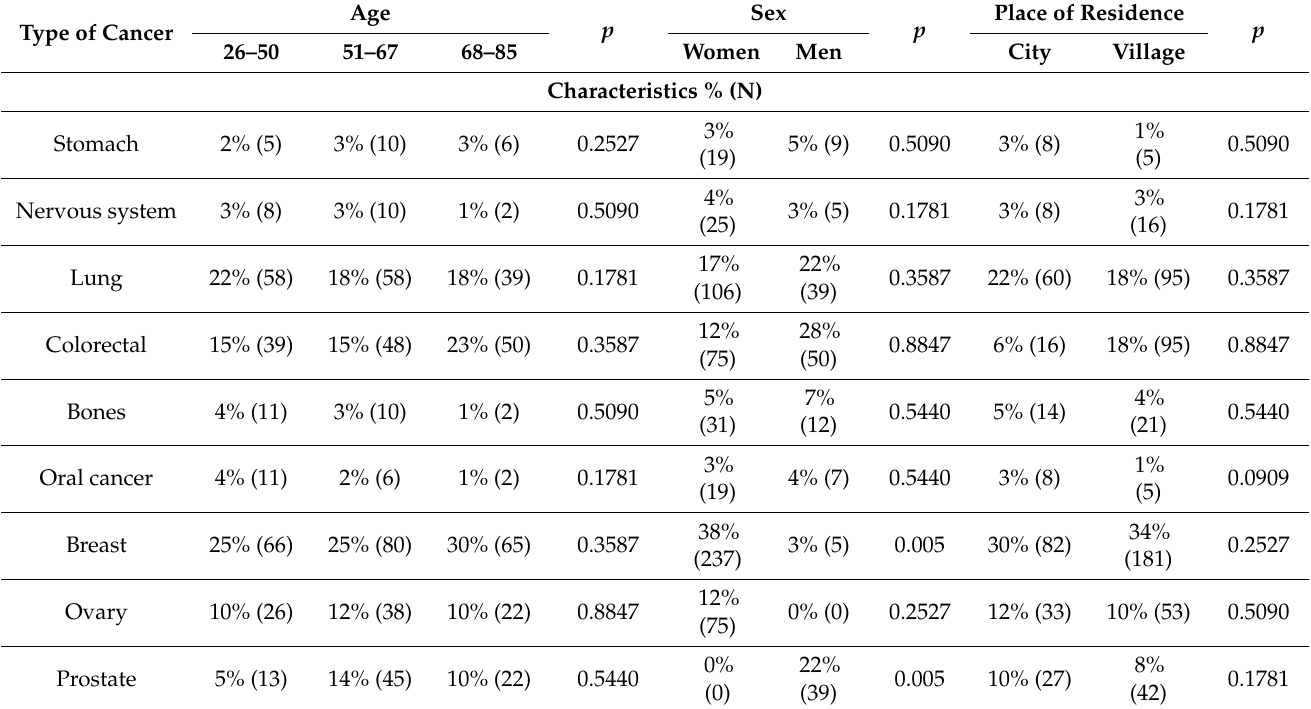
Table 2. Incidence of neoplasms among